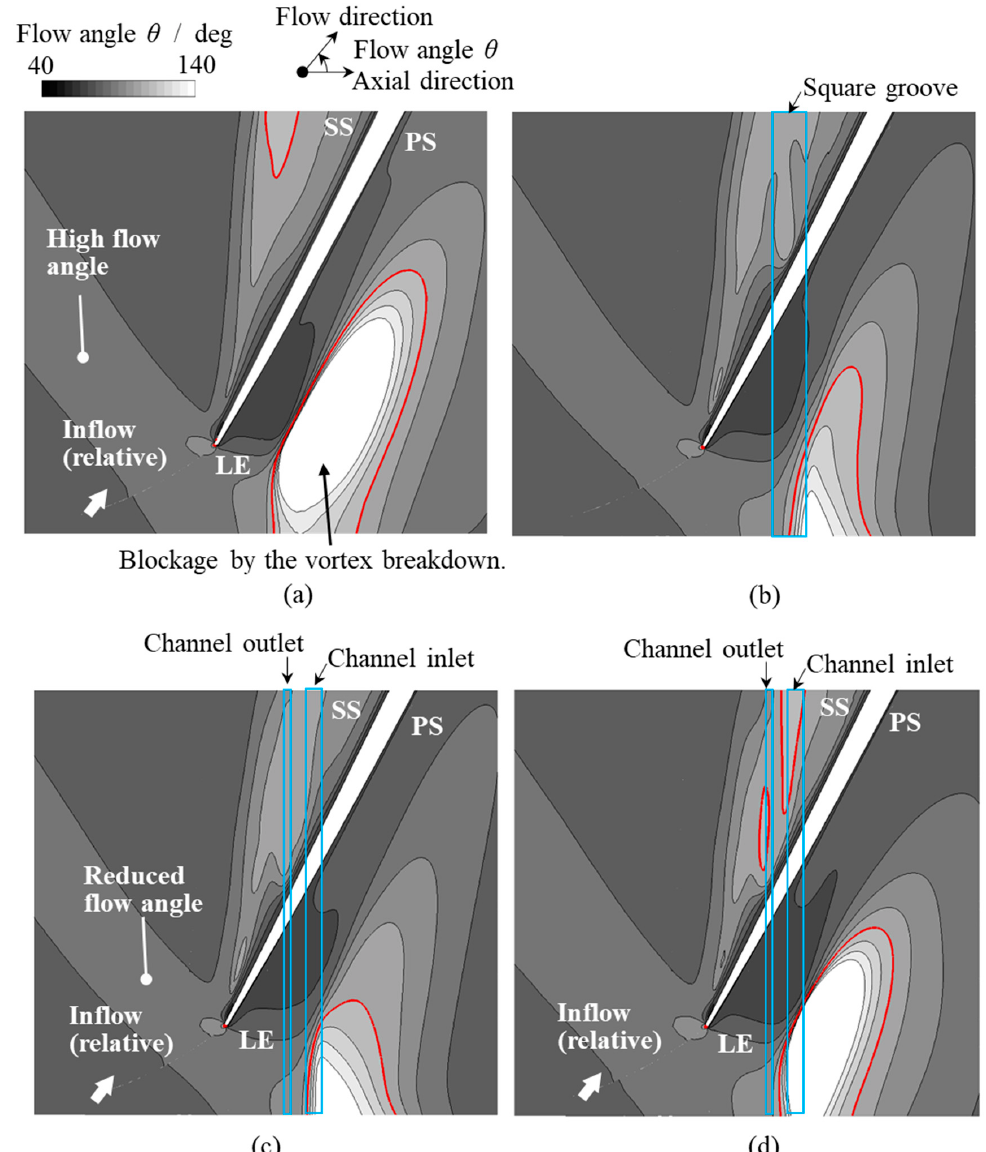
Figure 10. Contours of flow angle showing the flow structure near the rotor blade LE at 0.99 blade span. ( a ) BL (OP-D); ( b ) SG (OP-D); ( c ) RC (OP-D); ( d ) RC (NS). span. ( a ) BL (OP-D); ( b ) SG (OP-D); ( c ) RC (OP-D); ( d ) RC